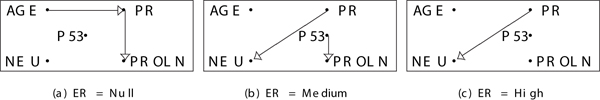
MultiDAG for the distinguished variable ER. DAGs belonging to equivalence class of structures for each value of the distinguished variable ER.